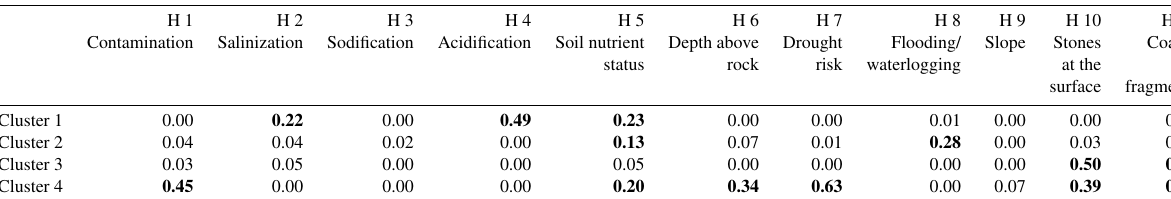
Table 6. Mean influence values (0: no influence; 1.0: maximum influence) of hazard indicators (H 1–11) for clusters of marginal case study sites (numbers in bold are the dominating values for the respective cluster).